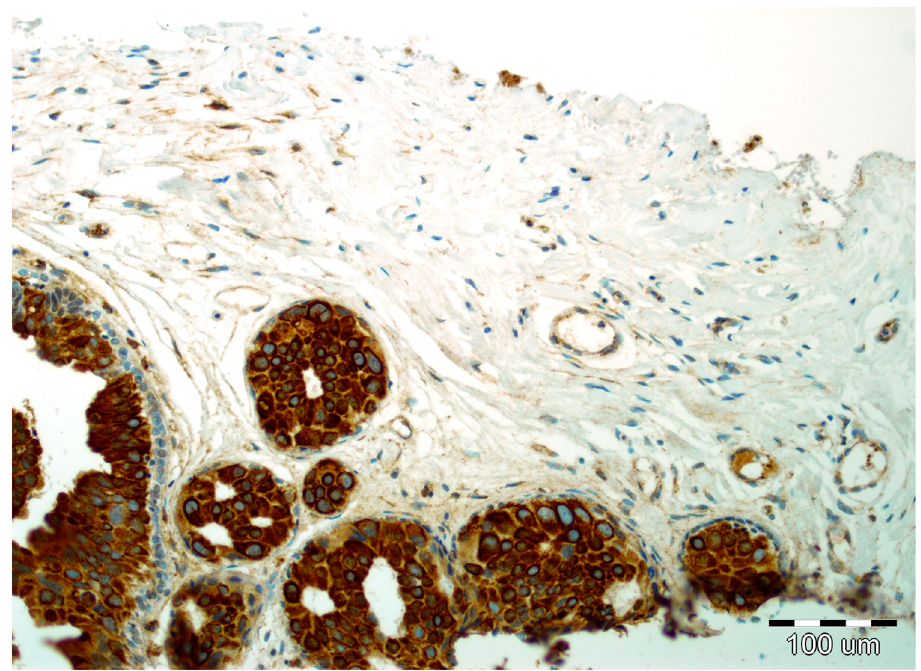
Figure 4. Strong expression of SPARC in DCIS luminal epithelial cells and focal reactivity in the stromal compartment with lack of reactivity in myoepithelial cells (hematoxylin, ×200).